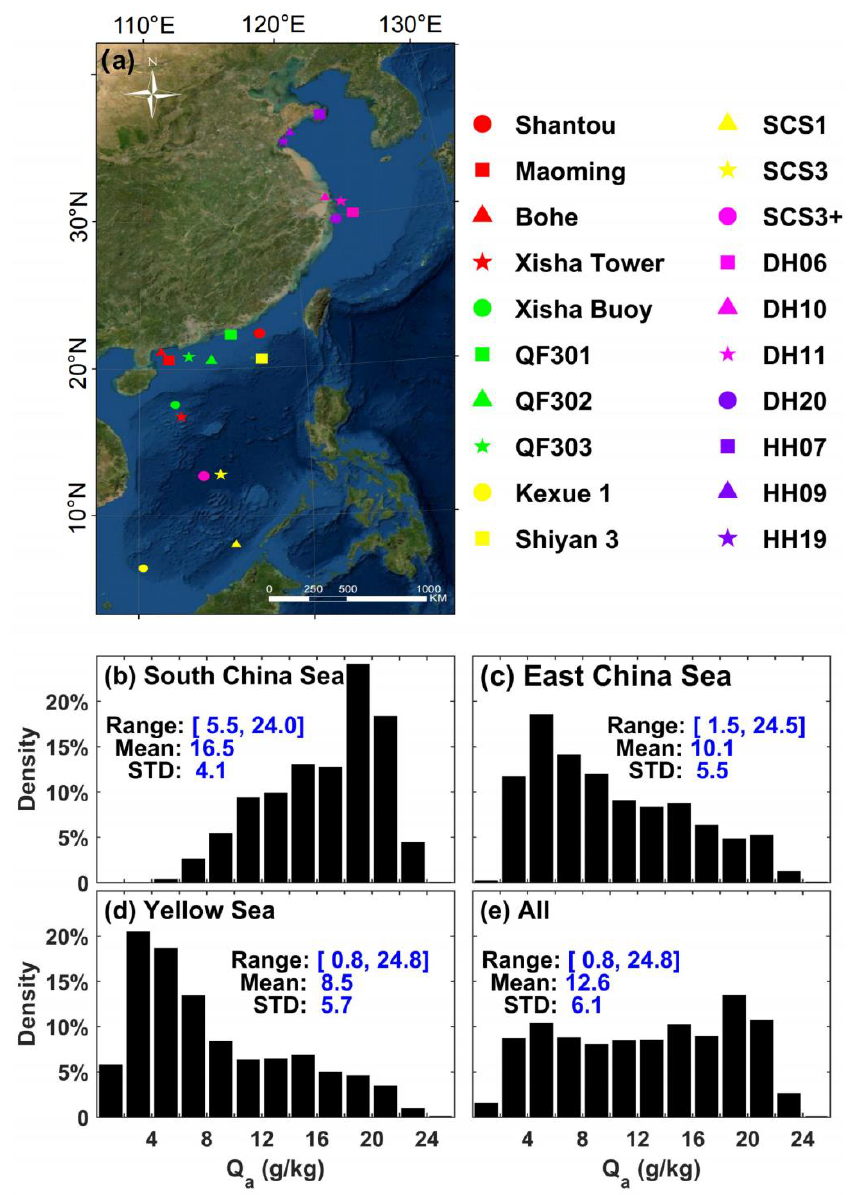
Figure 1. ( a ) Geographical distribution of observational stations. Shading denotes the ocean depth. ( b – d ) The PDDs of in situ observations of Q a over the SCS, ECS, and YS. ( e ) The mean results for all data. The range, mean value, and STD of the data in each panel are shown in blue text with unit of g/kg. Table 1. Information on in situ observations collected in this study. The station names with prefixes “DH” and “HH” are located in the ECS and the YS, respectively. The remaining 13 stations are located in the SCS. The data span from 1998 to 2018 and the sampling intervals vary from 1 min to 30 min.